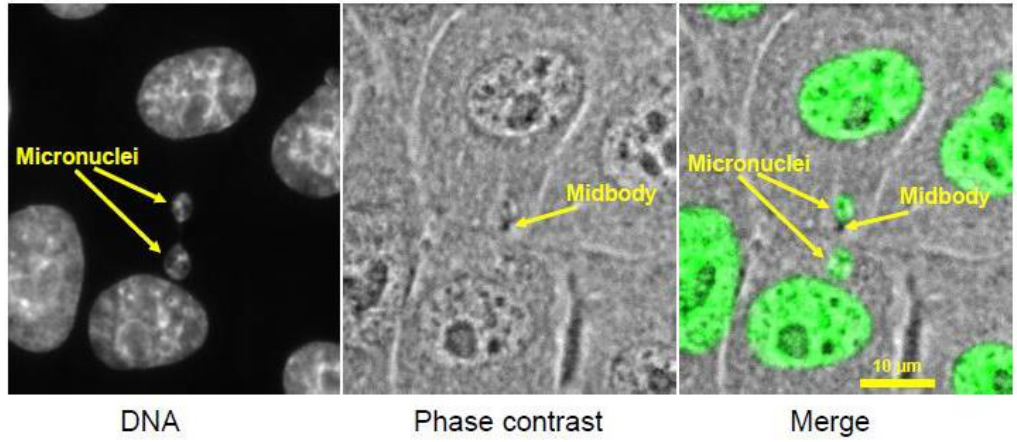
Figure 5. Micronuclei present in two daughter LLC-Pk cells, a cell line derived from porcine kidney. Micronuclei likely formed from lagging chromosomes that were partially trapped in the cytokinetic cleavage furrow. The midbody, the remnant of the cleavage furrow, bisects the region between the two micronuclei. (micrographs courtesy of Hem Sapkota.)